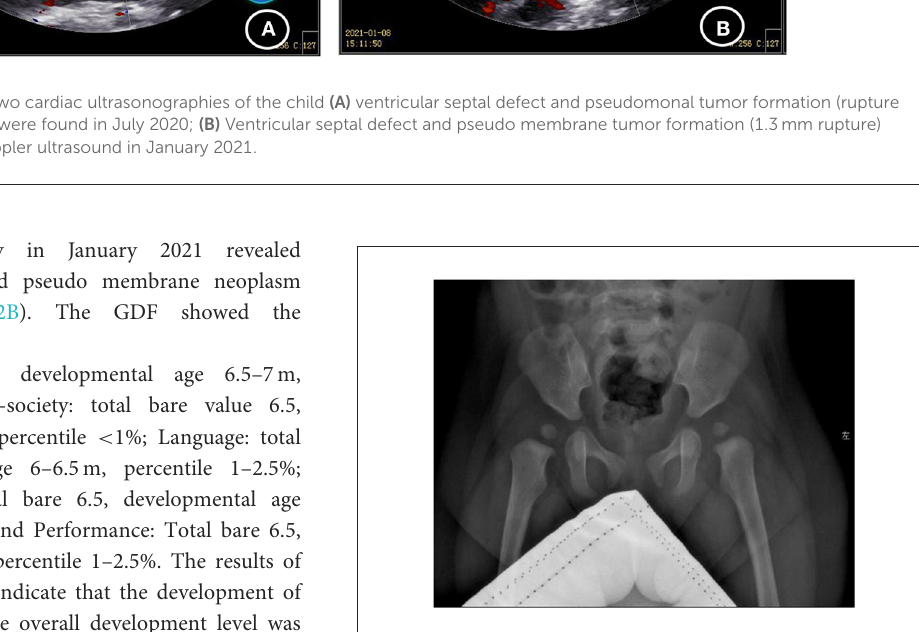
FIGURE3 Radiographs of the child’s hip joint show slightly flat and shallow bilateral acetabular fossa and enlarged bilateral acetabular